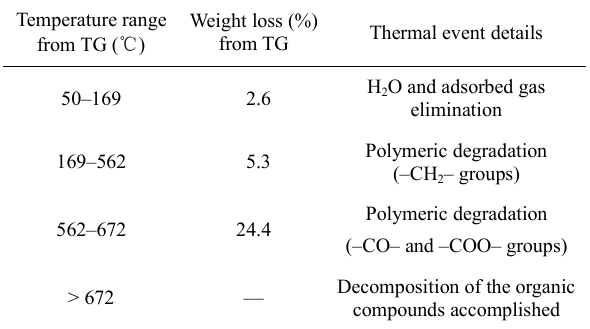
Table 1 Results of thermal analyses for the NiWO 4 sample Temperature range Weight loss (%) from TG from TG ( ℃ )